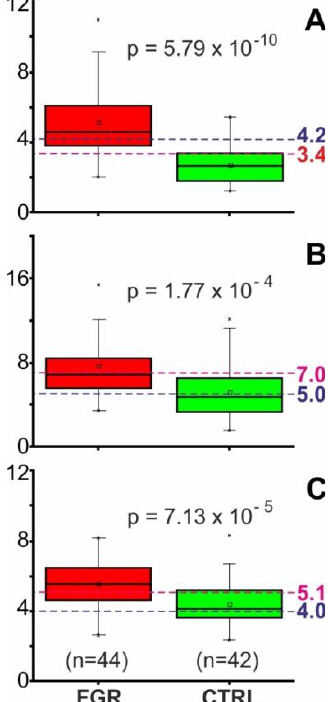
Figure 3. Distribution of quotient values for selected ion intensity differences of the “development” test set. Quotient values distributions are shown as box and whisker plots (second measurement series, MS2, of CTRL I and FGR I plus third and fourth measurement series, MS3 and MS4, of CTRL II and FGR II serum samples, n = 86). ( A ) Signal area of the ion at m/z 8916 over the signal area of the ion at m/z 8205. ( B ) Signal area of the ion at m/z 8766 over the sum of the signal areas of ions at m/z 9422 plus m/z 9713. ( C ) Signal area of the ion at m/z 8916 over the sum of signal areas of ions at m/z 8766 plus m/z 9422 plus m/z 9713. The boxes represent the 25th – 75th percentiles. The horizontal lines within the boxes represent the medians; the small squares indicate the means. The whiskers specify the 5th and 95th percentiles and the crosses indicate the 1st and 99th percentiles. Dashed lines mark selected cut-off values. Cut-off values for the quotients are ( A ) 3.4 and 4.2, ( B ) 5.0 and 7.0, ( C ) 4.0 and 5.1. FGR, fetal growth restriction; CTRL, control